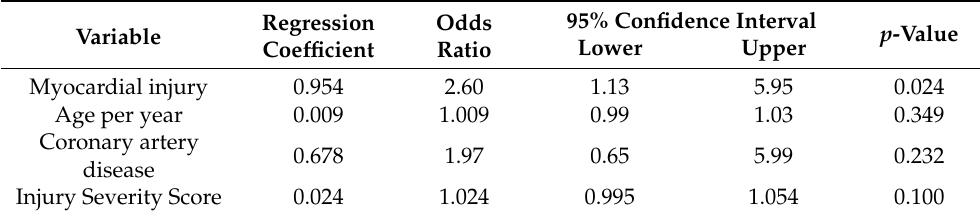
Table A1. Multivariate binary logistic regression model for myocardial injury and MACE, including the Injury Severity Score